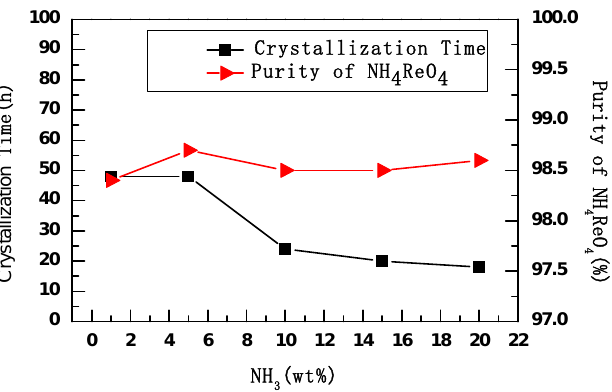
Figure 1. NH 3 (wt %)—conversion relation of crystallization time and purity.